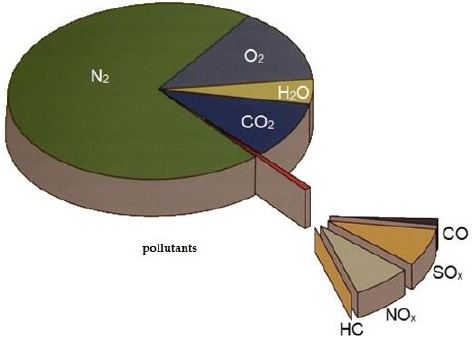
Fig. 1. The typical composition of exhaust gases from the modern, marine diesel engine (reproduced from